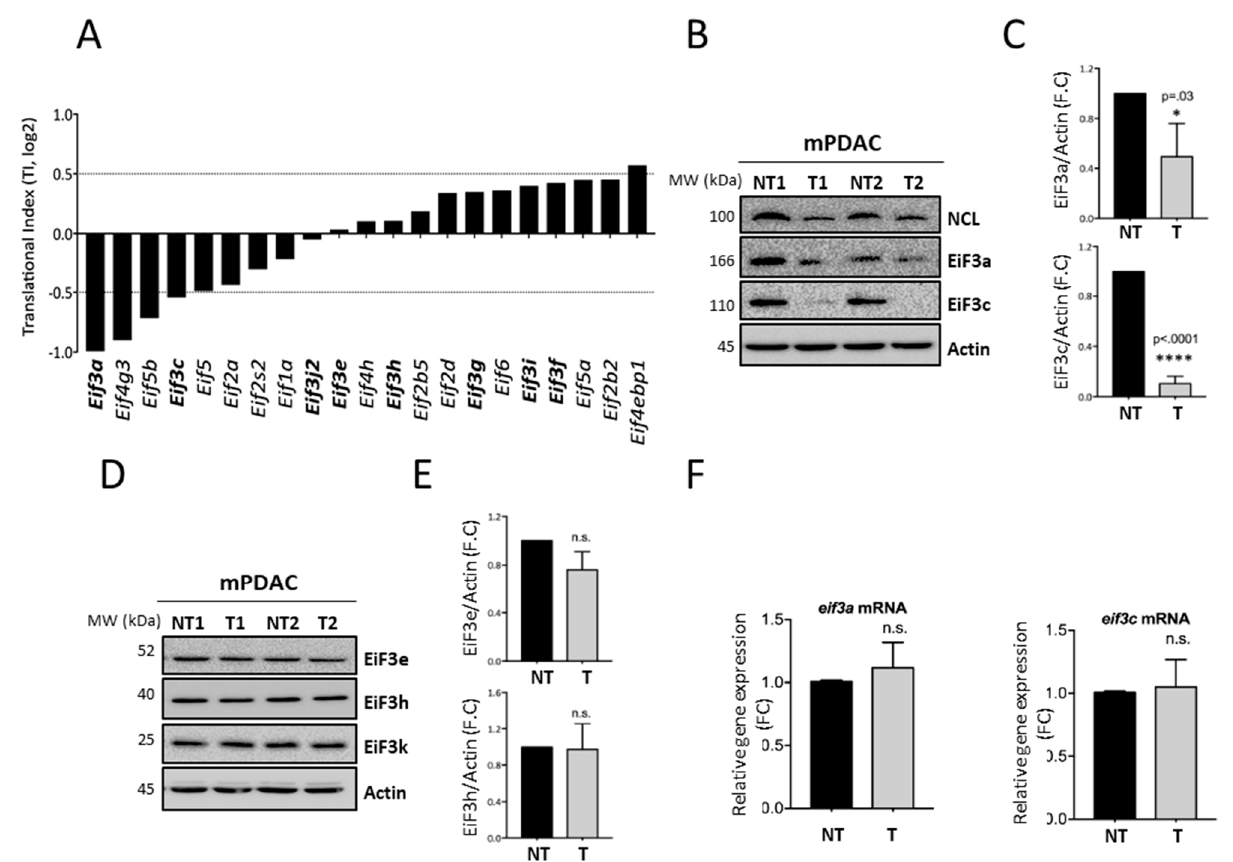
Figure 3. NCL targeting by N6L decreases the translation of mRNAs encoding the canonical subunits of EiF3 factor, Eif3a, and Eif3c. ( A )—Translation Index (T.I) for eukaryote initiator factors (eIF) mRNA under N6L treatment. ( B – E )—mPDAC cells were treated (T) or not (NT) with N6L for 48 h, following which EiF3 subunits protein expression was analyzed using Western blotting ( B , D ) and quantified in relation to actin ( C , E ). ( F )—Validation of relative eIF3a and eIF3c expression using RT-QPCR in mPDAC treated or not with N6L after normalization to the actin housekeeping gene. p < 0.05; and n.s. for not statistically significant, as determined by Student t -test on final data